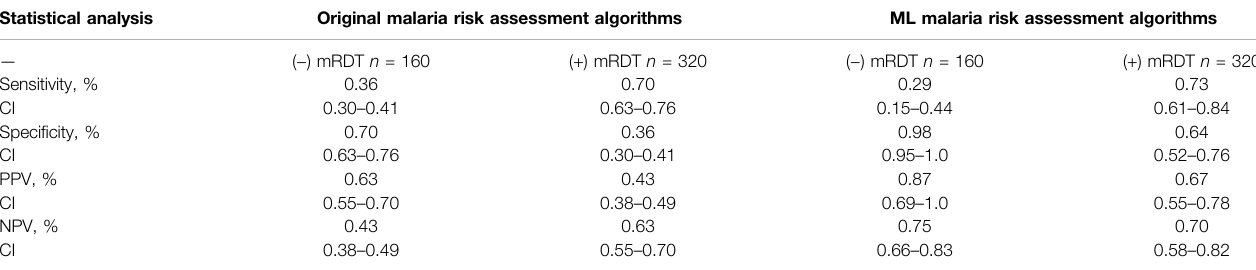
TABLE 7 | Performance statistics of THINKMD ’ s original malaria risk algorithms and the ML malaria risk algorithms vs performed mRDTs. Statistical